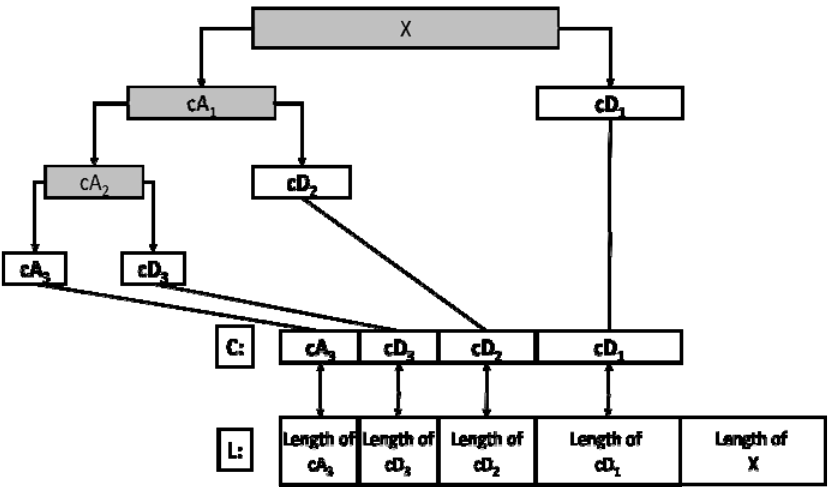
, D , .., D the details 1 2 n